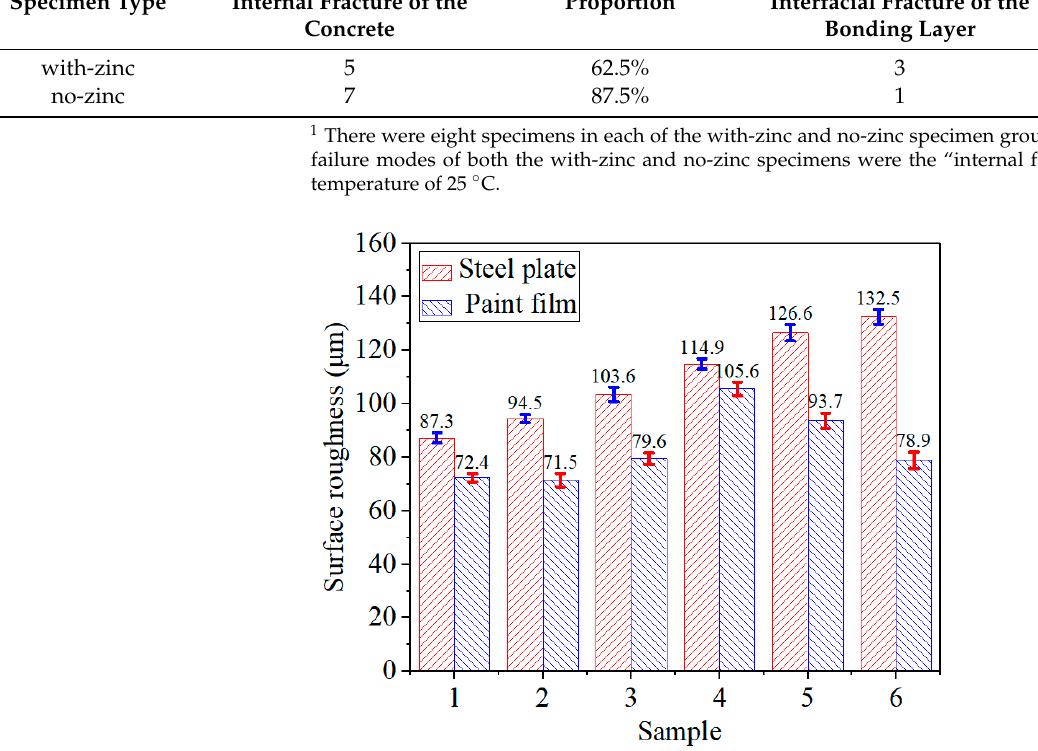
Figure 12. Comparison of the surface roughness of the steel plate and the primer. (Samples 1–6 are a series of samples with a roughness range of 80–150 μ m).